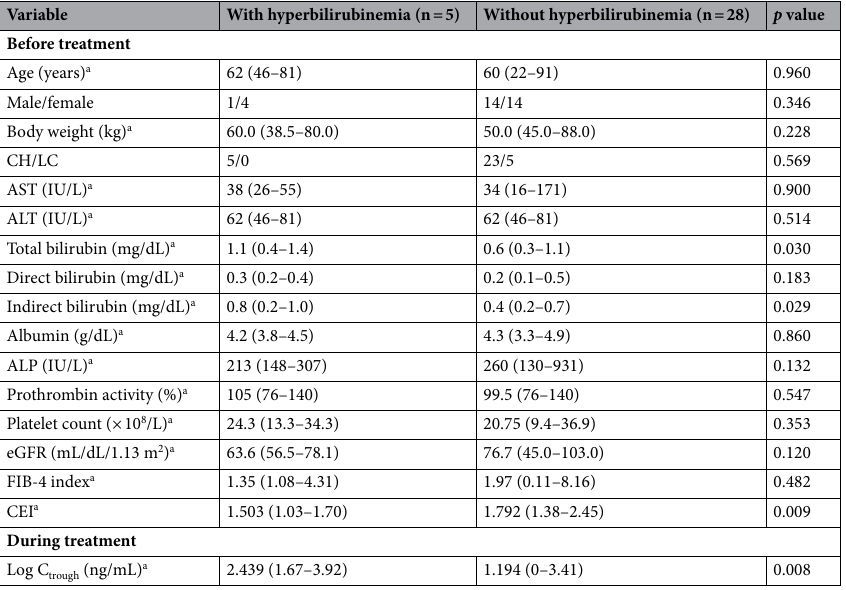
Table 3. Variables in patients with and without grade ≥ 2 hyperbilirubinemia before and during treatment. AST aspartate aminotransferase, ALT alanine aminotransferase, ALP alkaline phosphatase, eGFR estimated glomerular filtration rate, FIB-4 fibrosis-4, CH/LC chronic hepatitis/liver cirrhosis, CEI contrast enhancement index, C trough trough concentration of glecaprevir. a Data are shown as median (range) values.